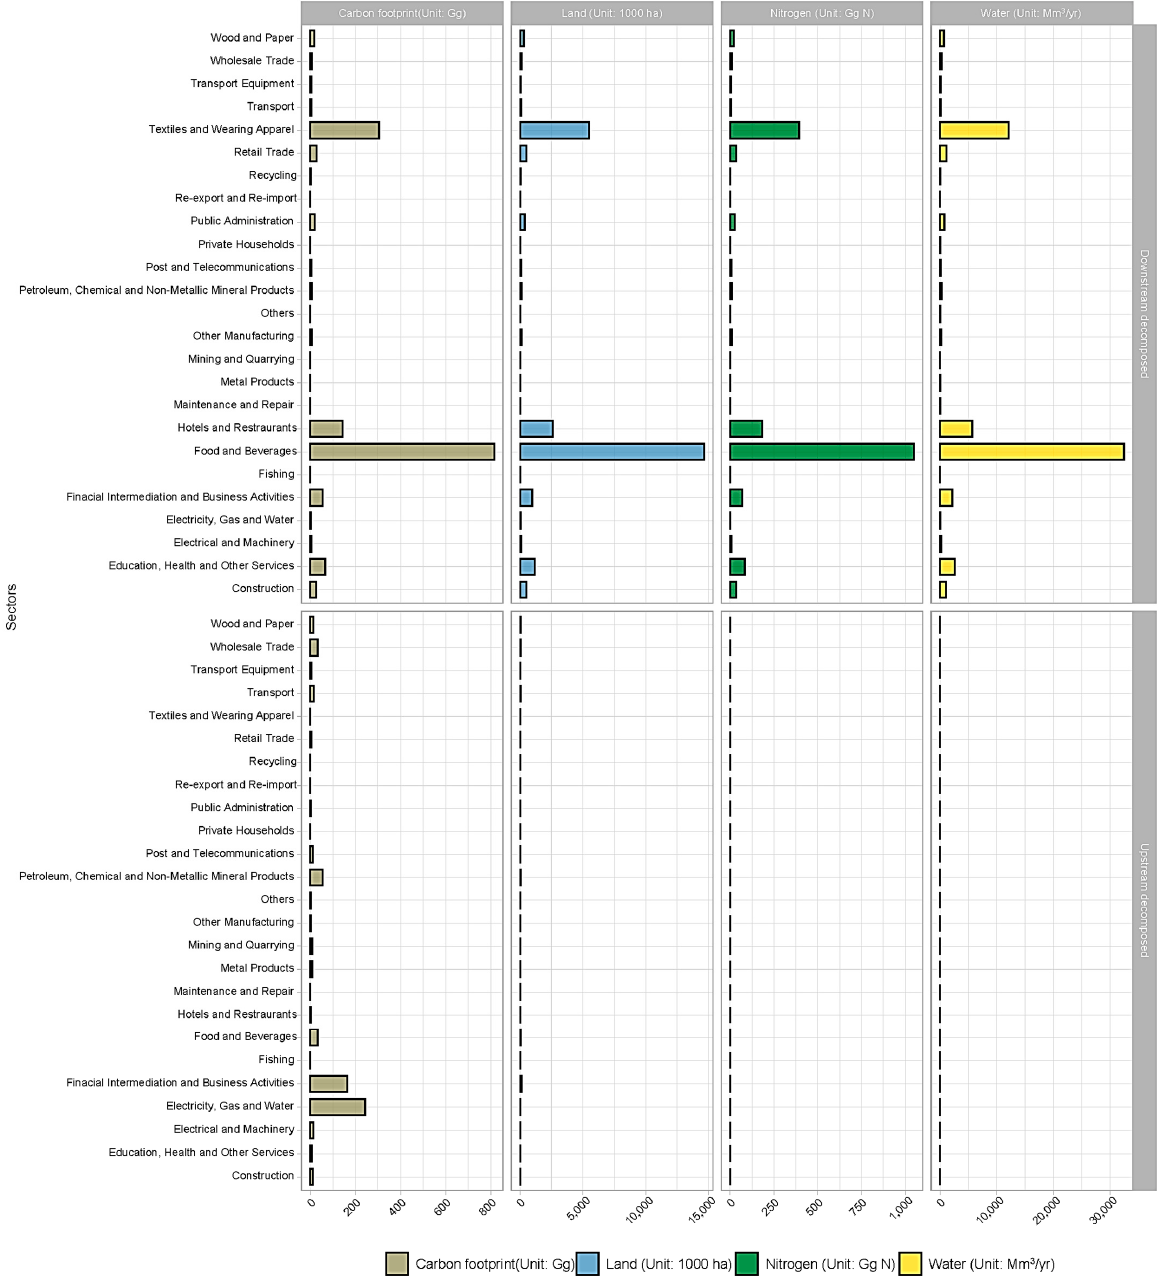
Figure 3. Agriculture sector’s decomposed upstream and downstream environmental impacts. Figure 4 illustrates the further decomposition of the agriculture sector’s water use and nitrogen emissions impacts in Pakistan. Again, downstream purchases from the sec- tors of “Food and Beverage”, “Textiles and Wearing Apparel”, and “Hotels and Restau- rants” had the greatest impact on blue and grey water usage, as well as the agricultural sector’s N 2 O, NH 3 , NOx, and N discharges. The sector of “Petroleum, Chemical, and Non- Metallic Mineral Products” had the greatest indirect upstream blue and grey water use